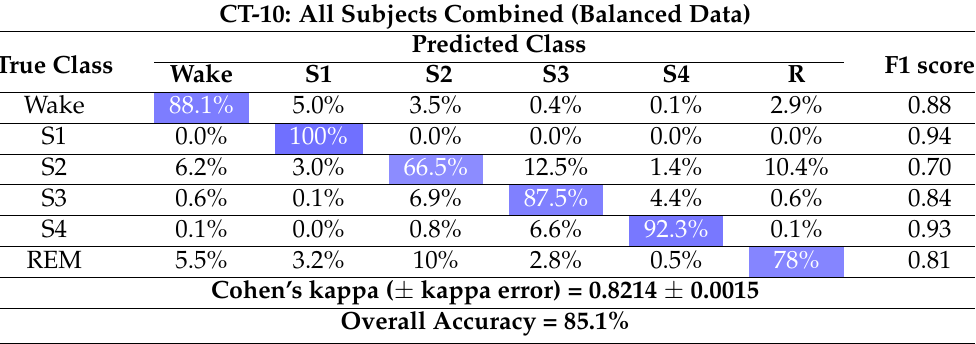
Table 28. Confusion matrix corresponding to sleep stage classification of all patients combined with balanced data using the EBT classifier with 10-fold CV.